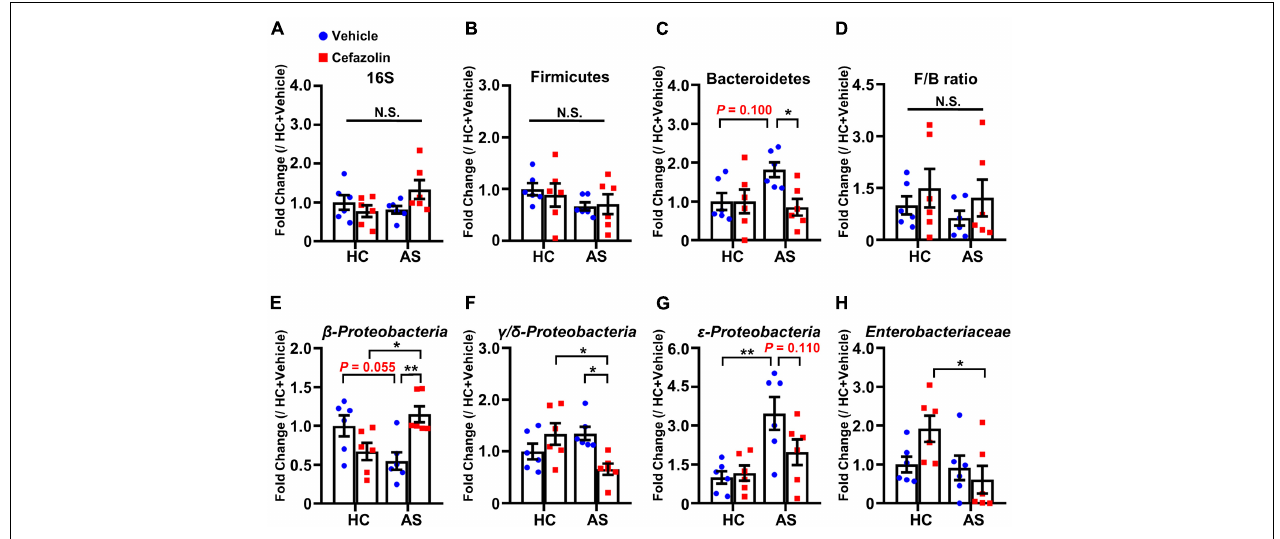
FIGURE 4 | Cefazolin changed the composition of fecal bacteria in the HC and AS groups. (A) 16S rRNA, (B) Firmicutes, (C) Bacteroidetes, (D) F/B ratio, (E) β -Proteobacteria , (F) γ / δ -Proteobacteria , (G) ε -Proteobacteria , and (H) Enterobacteriaceae . Data are shown as mean ± S.E.M. ( n = 6 in each group). * P < 0.05 or ** P < 0.01. AS: anesthesia and surgery; HC: healthy control; N.S.: not